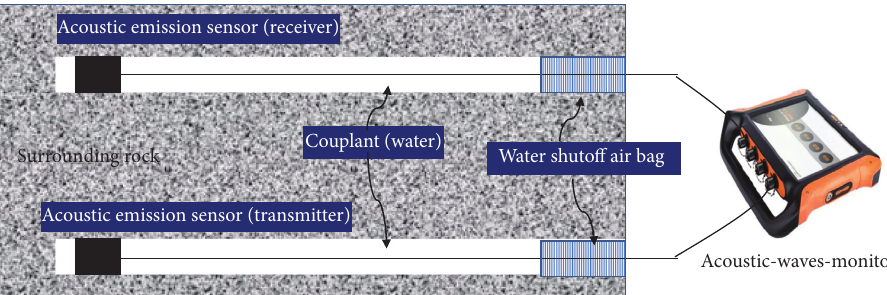
Figure 6: Schematic diagram of acoustic double-hole test